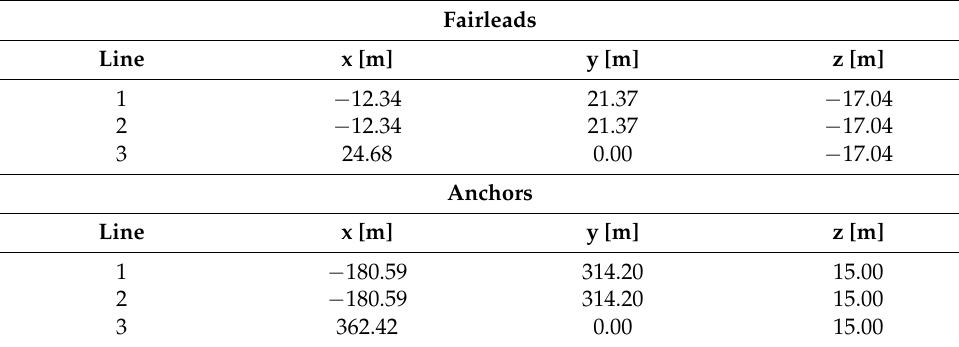
Table 3. Fairleads and anchors positions.